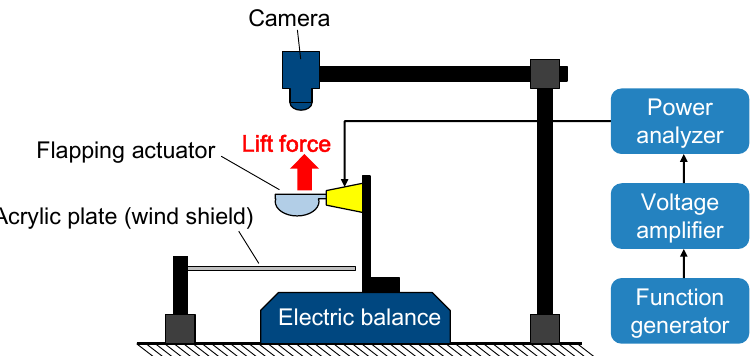
Figure 6. Setup for wing motion, lift force, and power consumption measurement.